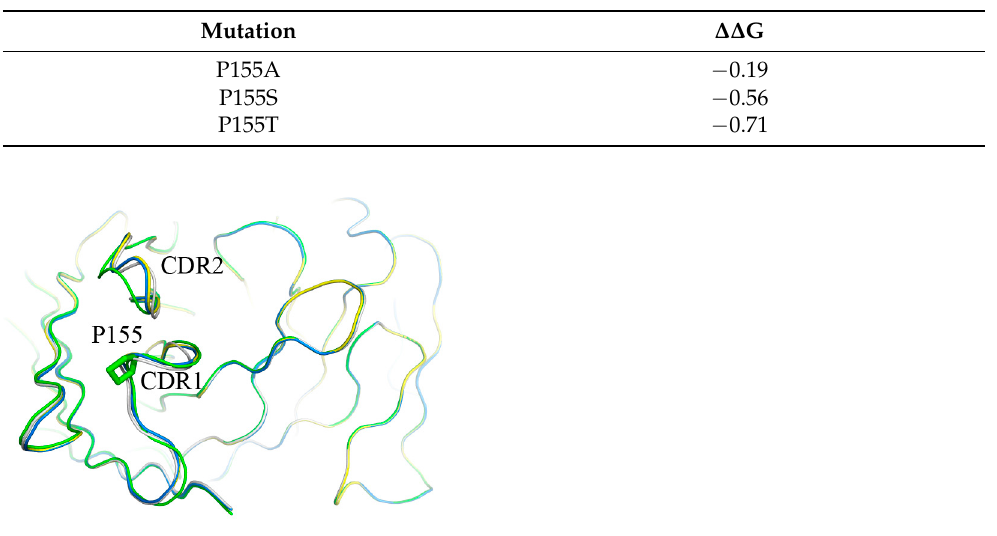
Table 3. The predicted free energy changes upon residue substitutions at position 30 of heavy chain.